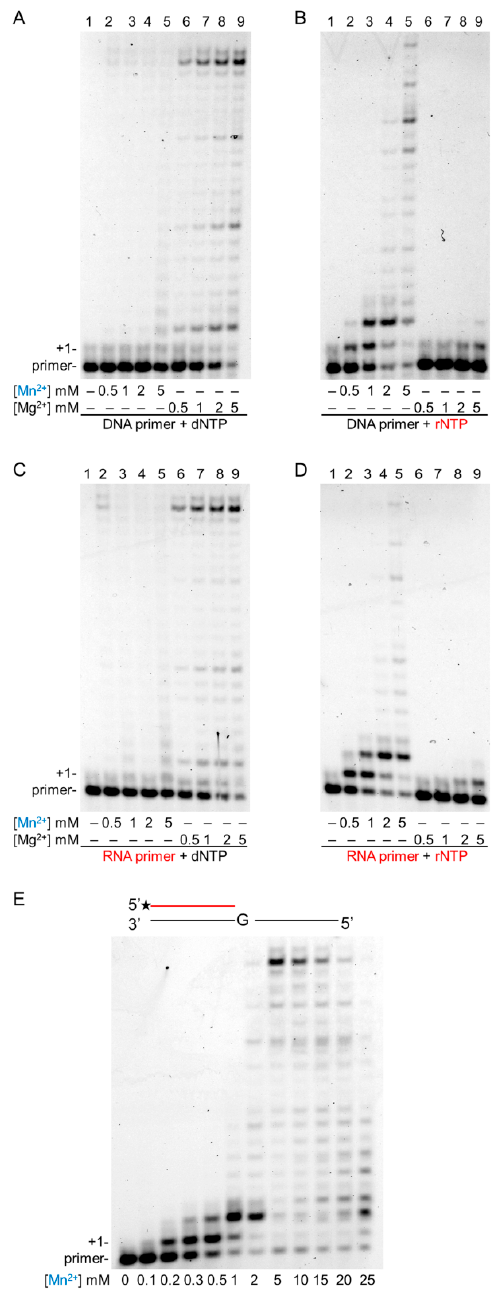
Figure 2. Effect of increasing concentrations of magnesium and manganese ions on the primer extension activity of Pol η in the presence of dNTPs or rNTPs. ( A – D ) Reactions were performed for 5 min with 10-nM Pol η in the presence of 20-nM primer/template, and close to physiological concentrations of nucleotides, either 50-µM dNTPs, or 1-mM rNTPs. ( A ) DNA primer (S3) and dNTPs, ( B ) DNA primer (S3) with rNTPs, ( C ) RNA primer (S7) with dNTPs, and ( D ) RNA primer (S7) and rNTPs. The concentrations of Mn 2+ and Mg 2+ are indicated below each panel. Lanes are numbered at the top. ( E ) Optimal manganese concentration needed for the highest activation of Pol η during RNA synthesis. Primer extension reactions containing the indicated concentration of Mn 2+ were performed for 5 min with 20-nM Pol η and 1-mM rNTP. The positions of the primer and its extension by one nucleotide are indicated. RNA primers and rNTPs are highlighted in red, and manganese in blue.